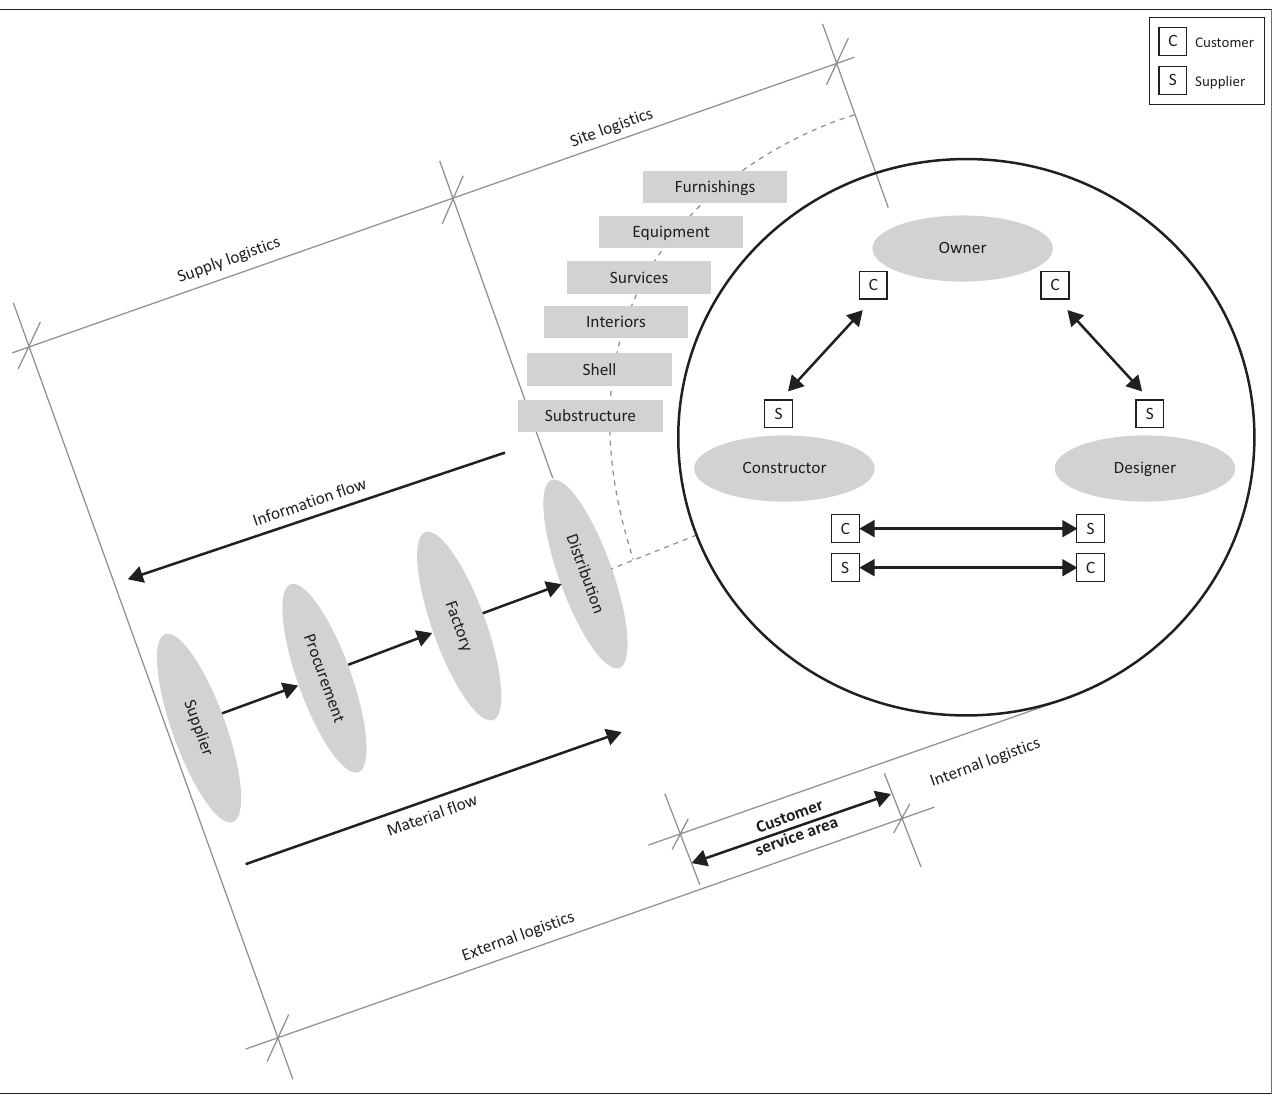
FIGURE 1: Juan’s triple role and construction logistics